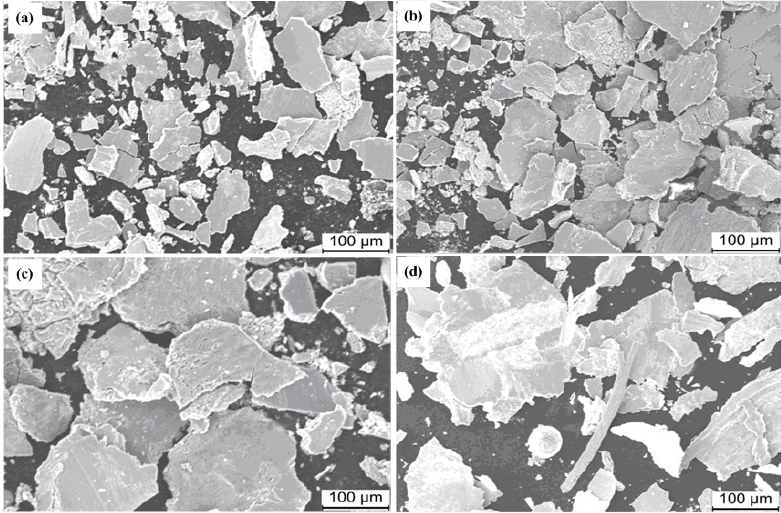
Figure 10. Morphologies of worn debris of 18Ni(300) maraging steel under ( a ) 100 N and 30 m/s, ( b ) 150 N and 40 m/s, ( c ) 250 N and 50 m/s, and ( d ) 300 N and 60 m/s.